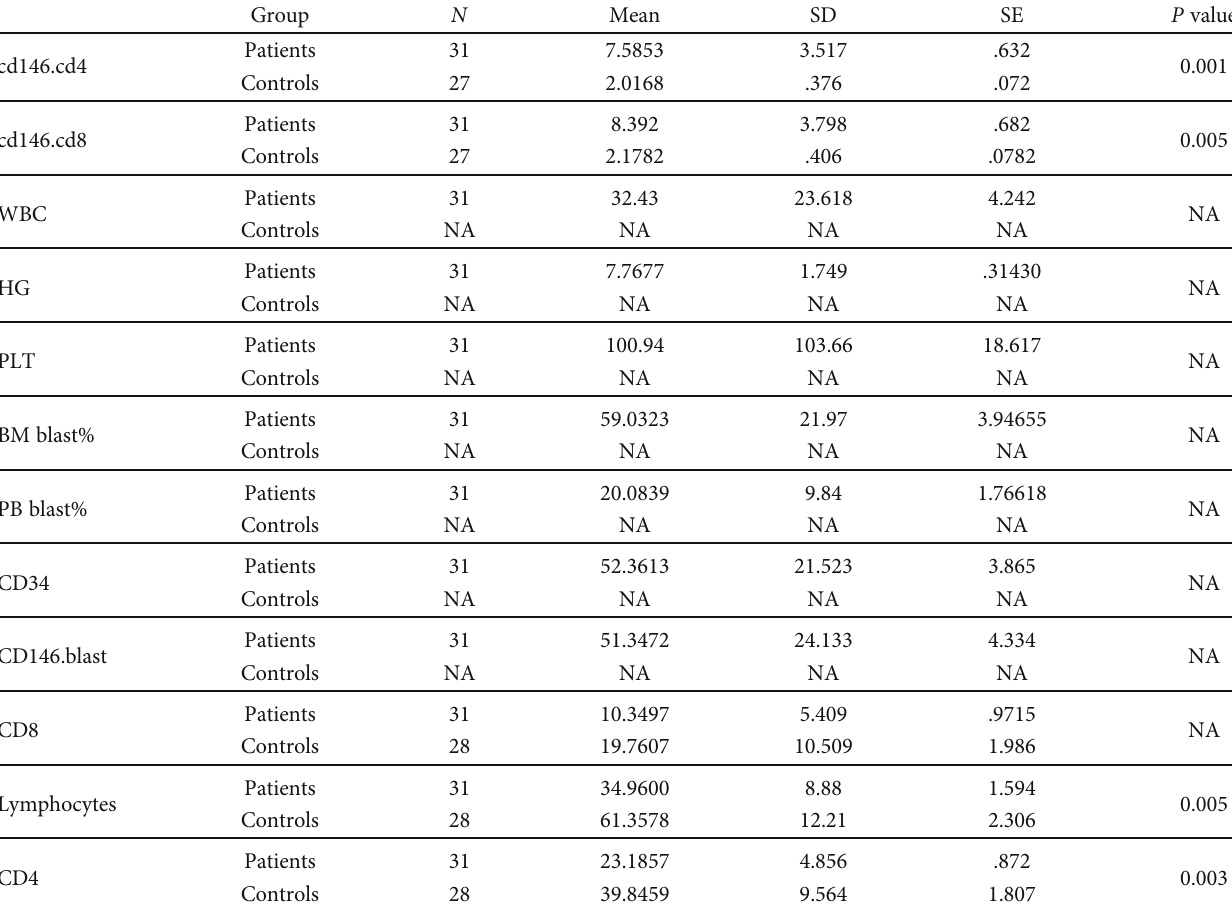
Table 2: Immune features of B-ALL patients and their controls with signi fi cance. Group